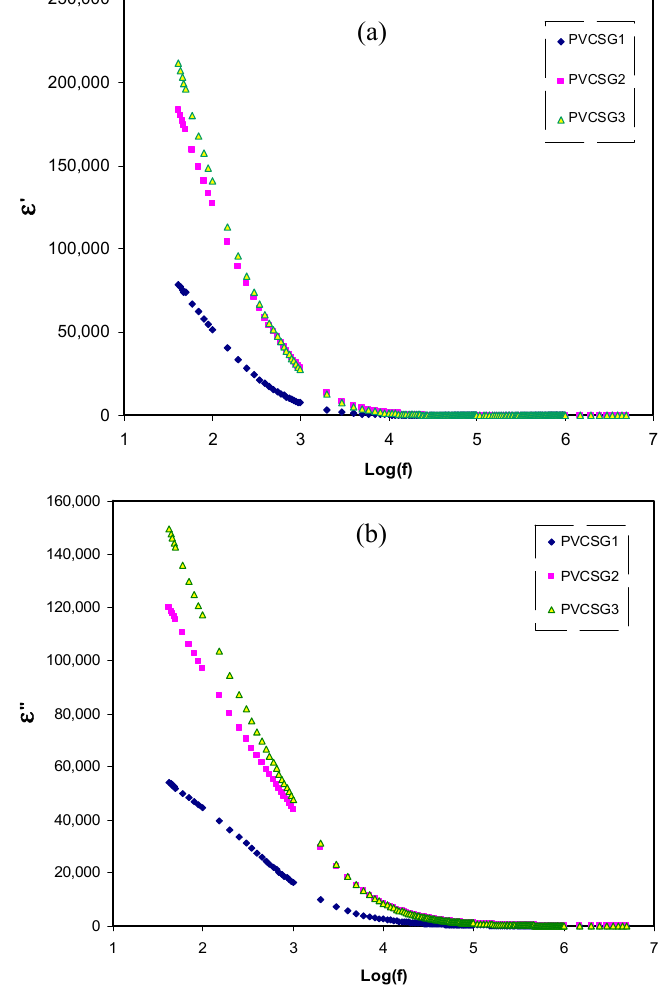
Figure 2. Dielectric parameters of ( a ) dielectric constant and ( b ) dielectric loss vs. log(f) for all plasticized electrolyte samples.